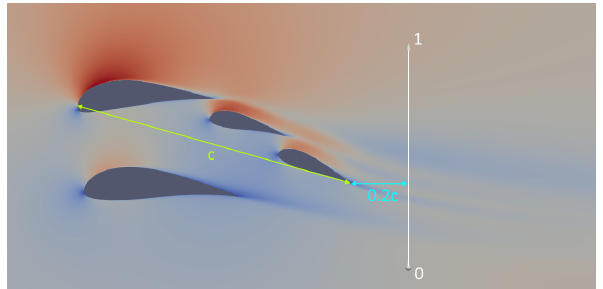
Figure 19. An example of the position of one of the vertical lines through the